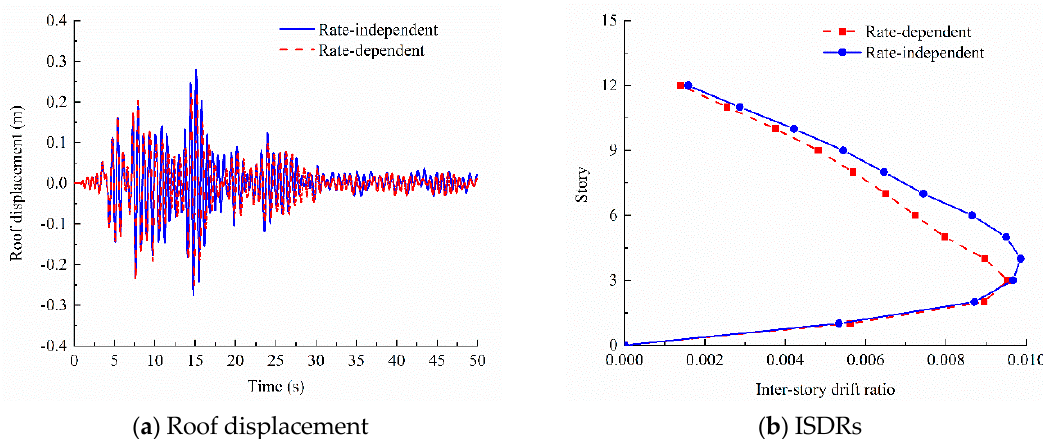
Figure 10. Comparison of the rate-dependent and rate-independent numerical results of roof displacement and ISDRs (Taft PGA = 0.8 g). Table 1. The influence of strain rate on a structural seismic response.